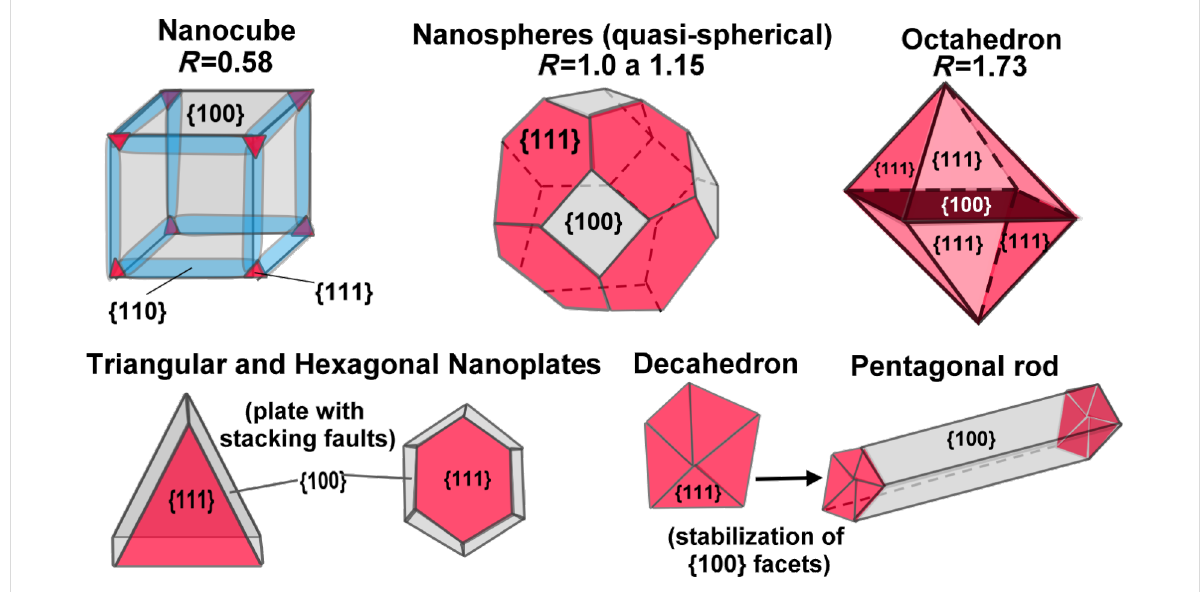
Figure 2: Geometric shapes of nanocrystals with their predominant facets in each structure and the ratio of {111} facets in relation to {100}. Redrawn from [36].